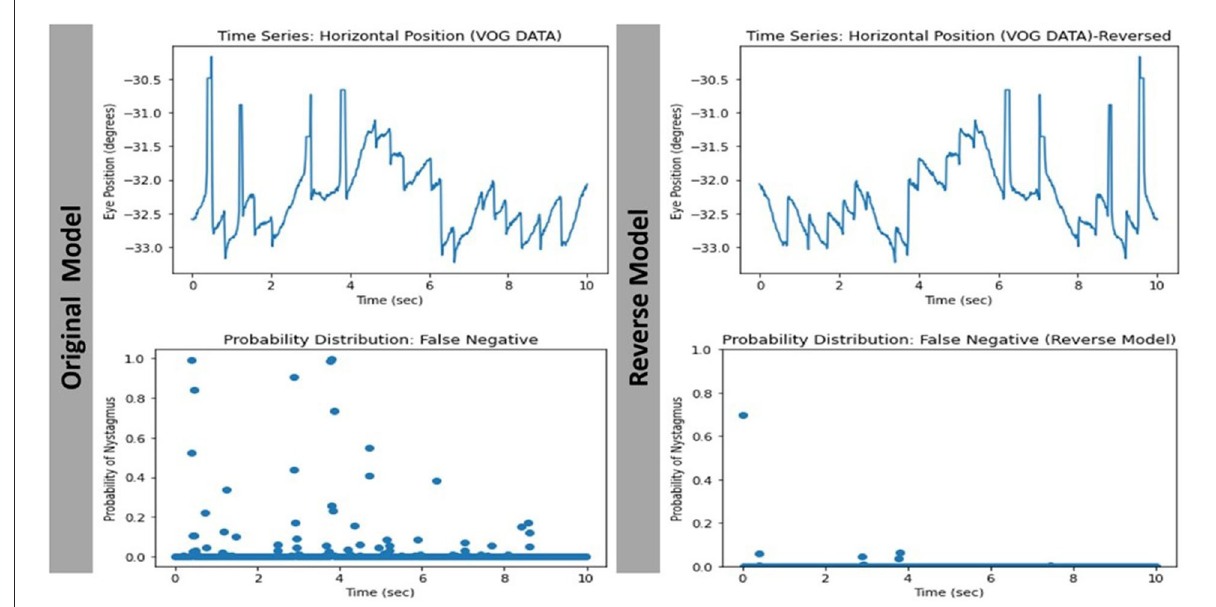
FIGURE8 Comparing the filtered-image probability distribution of the same false negative video with nystagmus in eccentric eye position toward the end of